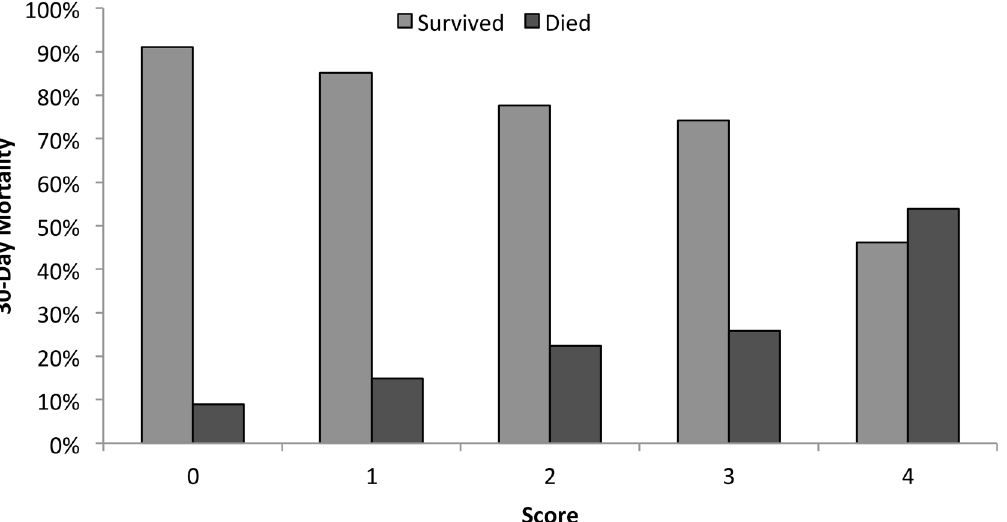
Fig 2. 30-day vital status for patients with each clinical predictor score. p < 0.0001 for the difference in mortality across clinical predictor score